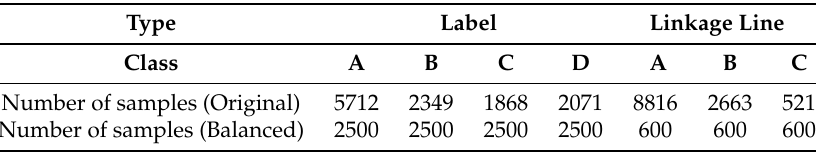
Table 2. The numbers of instances in each